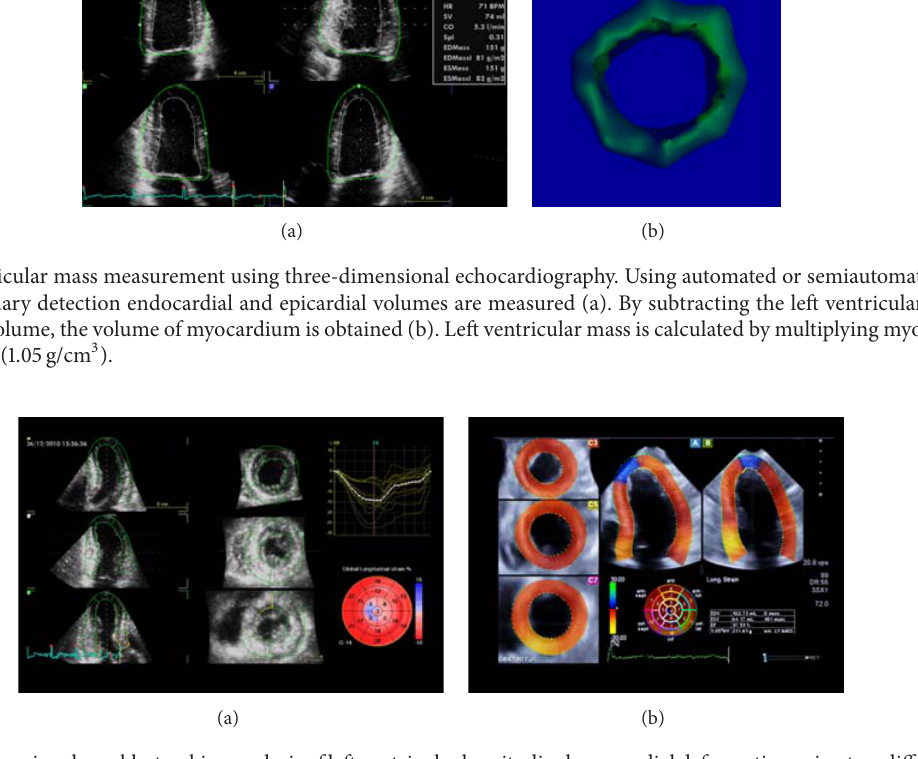
Figure14:Three-dimensional speckle-tracking analysisofleft ventricularlongitudinal myocardial deformationusingtwo differentplatforms. Results can be displayed as bull’s eye plots and/or time-strain